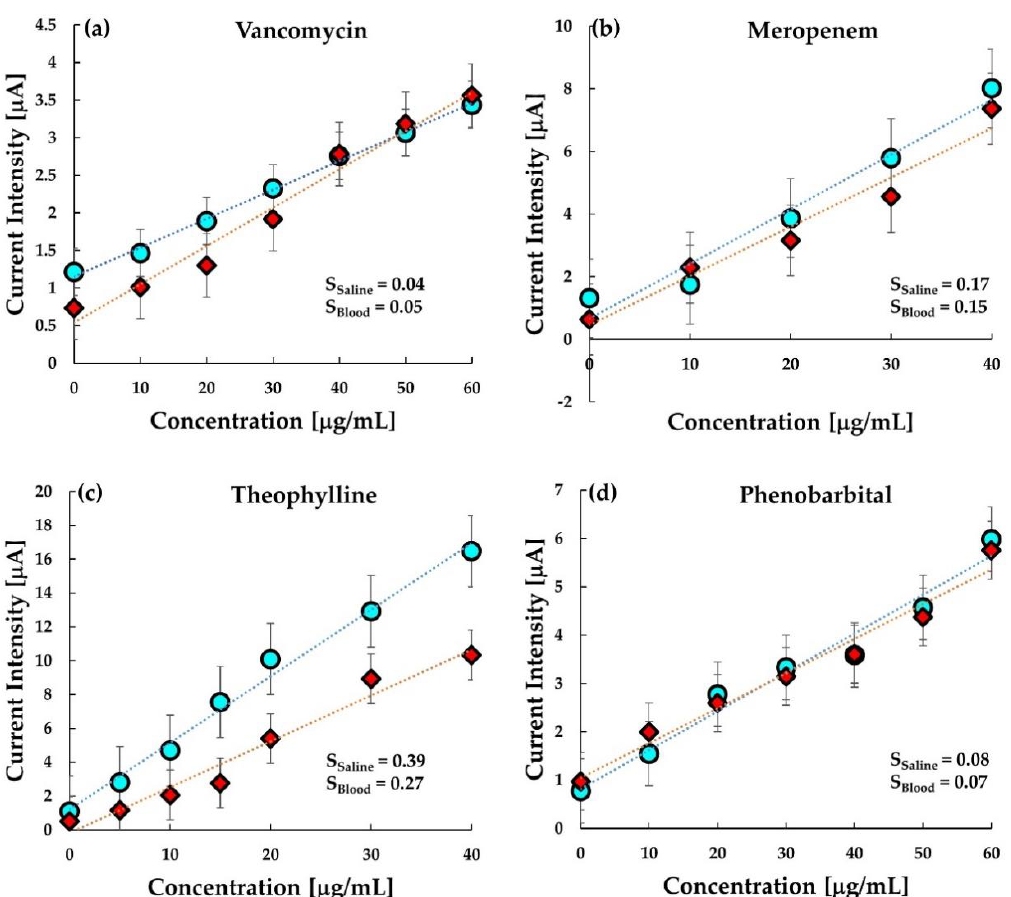
Figure 7. The comparison of MIP sensor response in saline and in blood for ( a ) vancomycin, ( b ) meropenem, ( c ) theophylline, and ( d ) phenobarbital. Circle ( ) represents response in saline, and rhombus ( ) represents response in whole bovine blood.